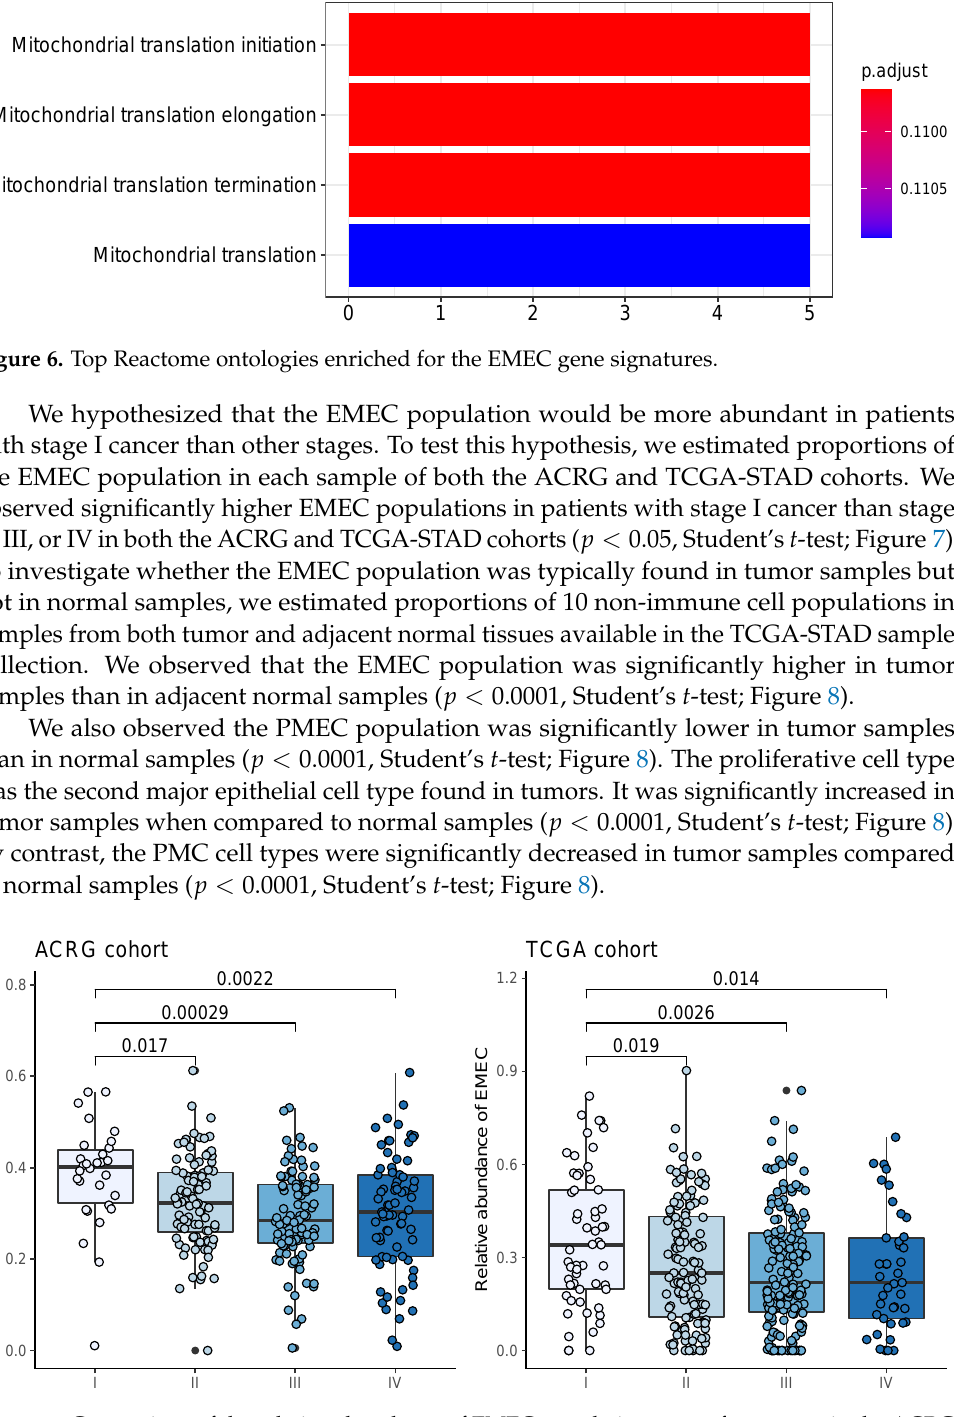
Figure 7. Comparison of the relative abundance of EMEC population across four stages in the ACRG and TCGA